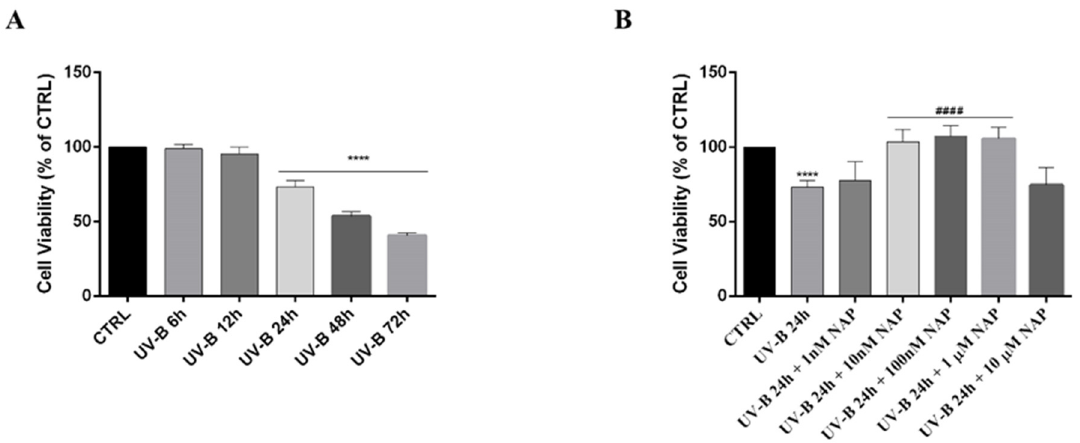
Figure 3. ( A ) Time–response curve following 30 s UV ‐ B ‐ irradiation of corneal epithelial cells. ( B ) Dose–response analysis of SIRC cells viability exposed to 30 s UV ‐ B irradiation to various NAP concentrations for 24 h. The bar graphs represent mean ± SEM of three independent experiments and values are expressed as % of CTRL. **** p < 0.0001 vs. CTRL; #### p < 0.0001 vs. UV ‐ B 24 h as determined by one ‐ way ANOVA followed by Tukey’s multiple comparison test. Twelve replicate wells were used for each group.